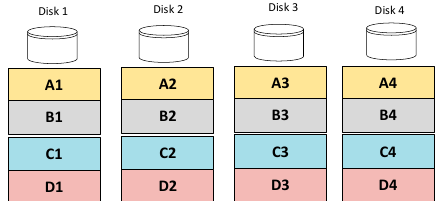
Figure 1. A 4-disk array in RAID5